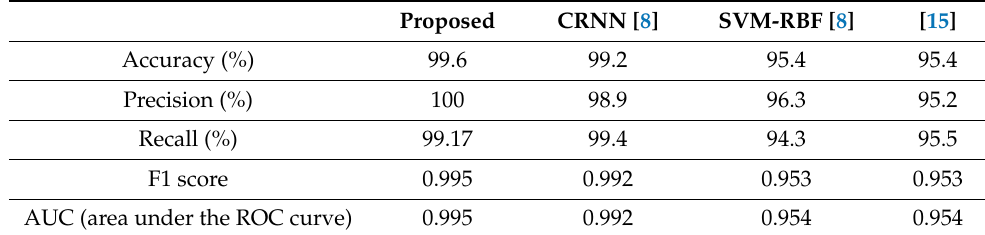
Table 5. Performance comparison of